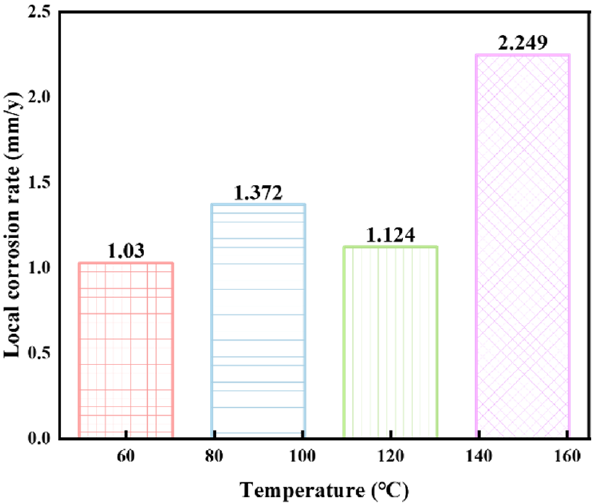
Figure 13. The local corrosion rate of T95 steel corroded in the liquid phase.